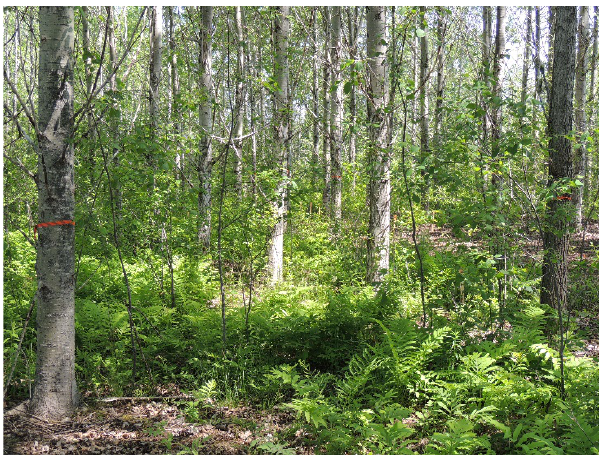
Figure 1. Hybrid poplar plantation understory with abundant glossy buckthorns.